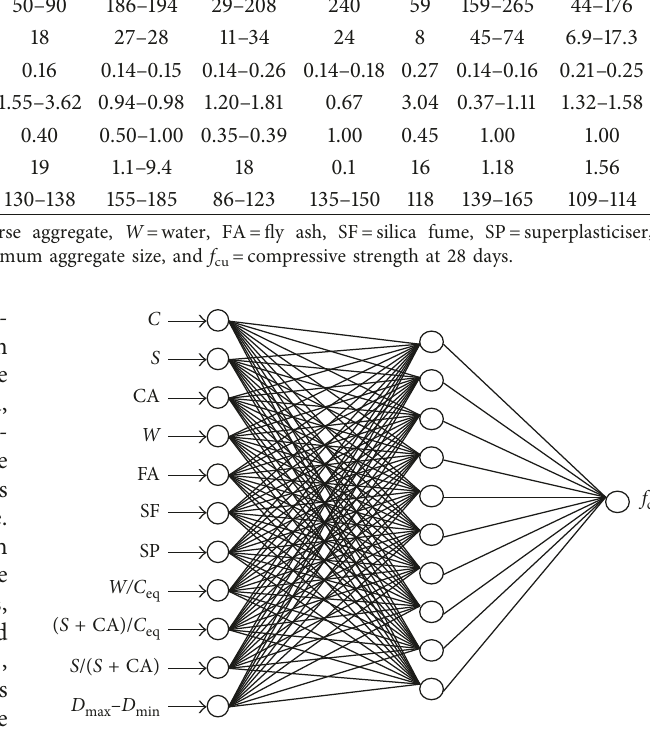
Figure 5: Constructed ANN model.